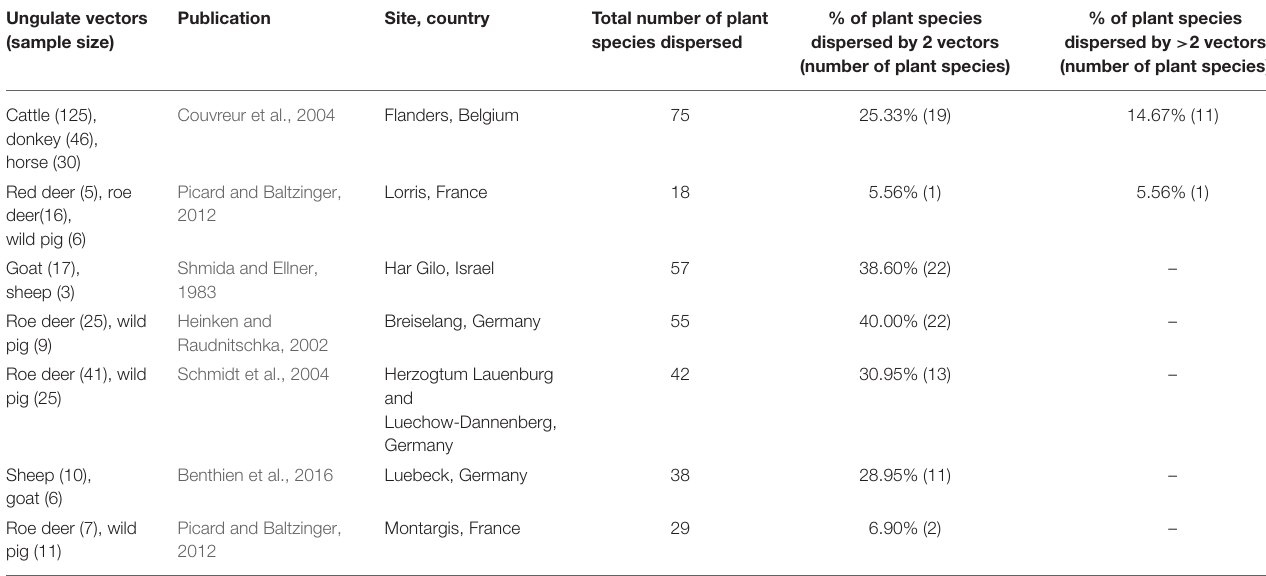
TABLE 4 | Studies on ungulate fur-epizoochory included in the overlap and complementarity of ungulate-mediated plant dispersal: ungulate sample size (given as number of brushed individuals), publication, location (site, country), total number of plant species dispersed, % of plant species dispersed by 2 vectors or more. Ungulate vectors (sample